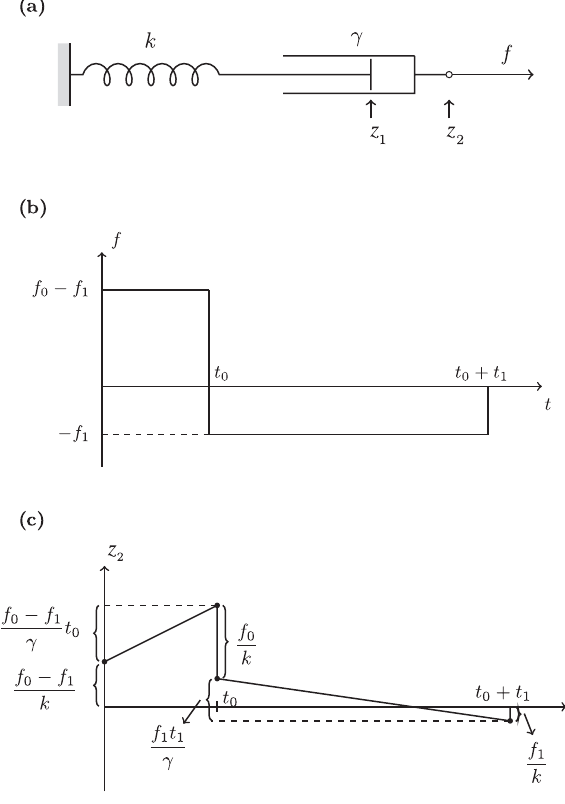
FIG. 4. The heuristic viscoelastic model used to discuss the enzyme cycle. (a) The Maxwell model of viscoelasticity: a spring of stiffness k and dashpot of dissipation coefficient (cid:2) . z is the position of the cylinder of the dashpot, z the position of 2 1 the piston of the dashpot. The force f is applied to the cylinder. (b) The force f vs time t used to drive the cycle in the model represents the driving force due to the interaction [Eq. (3)]. f 0 between the substrate and the enzyme; it is turned on at t ¼ 0 when the when the substrate binds and turned off at t ¼ t 0 is the internal restor- reaction and/or product release occurs. f 1 ing force of the enzyme (proportional to the free-energy gradient (cid:1) 0 . For in the absence of substrate), always present for z 2 and f are taken as constants. The time interval simplicity, f 0 1 t is chosen such that the system returns to the initial state at 1 þ t t ¼ t . (c) The corresponding response of the Maxwell 0 1 ð t Þ [Eq. element: z 2